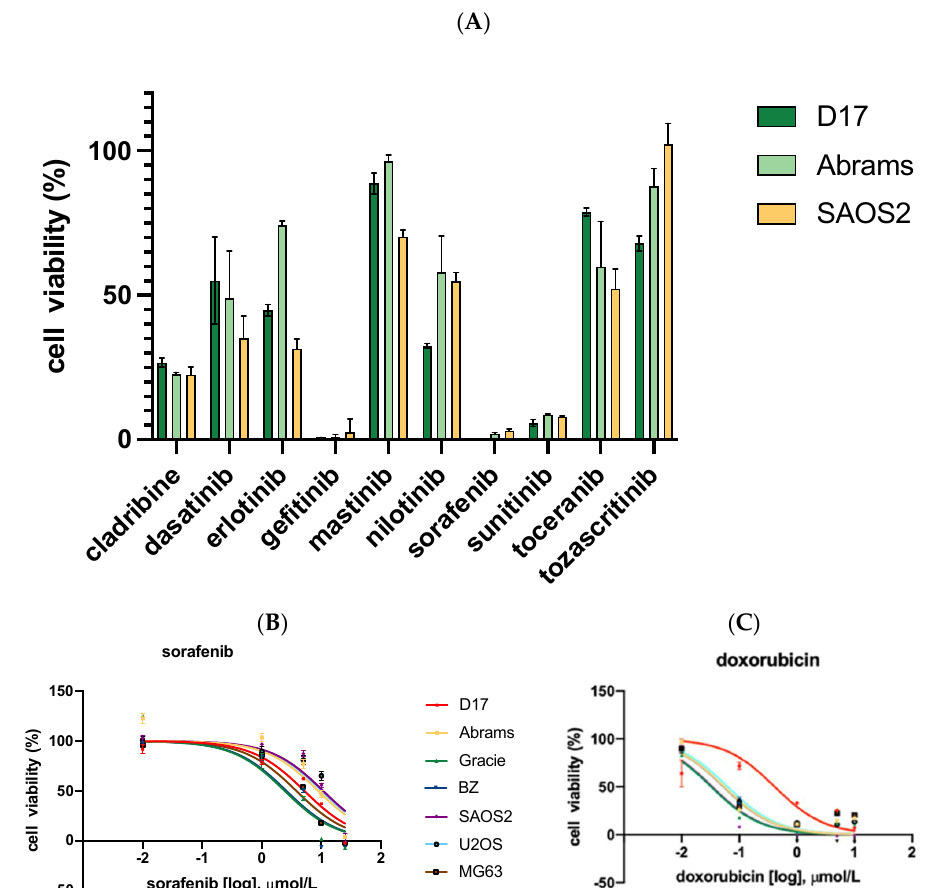
Figure 1. Cell viability was measured by CellTiter-Glo assay on all seven OSA cell lines, including four canine OSA (D17, Abrams, Gracie, and BZ) and three human OSA (SAOS2, U2OS, and MG63) cell lines. All cell lines were treated with drugs for 72 h. ( A ) Ten TKIs demonstrate different levels of inhibition on OSA cell viability. ( B ) OSA cell lines were treated with sorafenib for 72 h. ( C ) OSA cell lines were treated with doxorubicin.